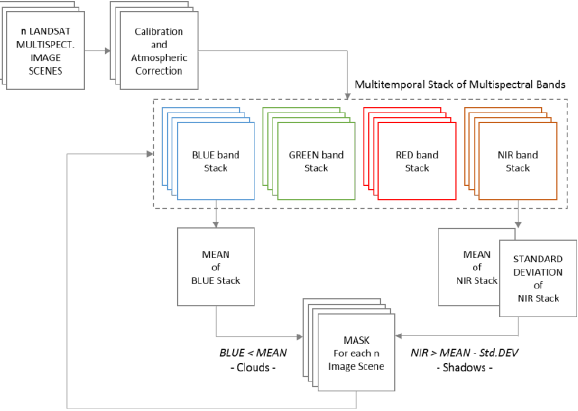
Figure 4. Workflow of the M2CTool masking algorithm (Source: Colaninno et al., 2019)